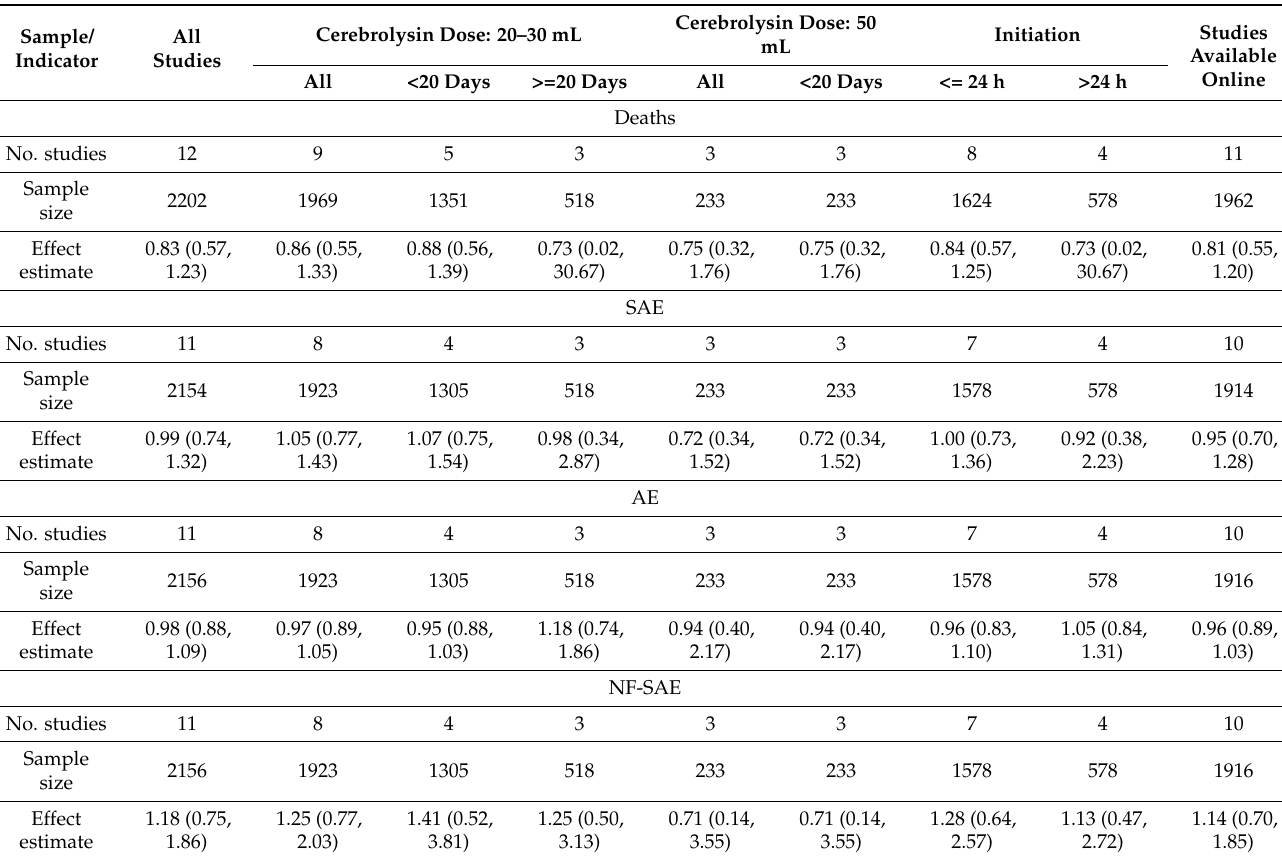
Table 3. Results of subgroup sensitivity analyses. Effect estimates risk ratios are computed using the Mantel–Haenszel method (M-H, random, 95% Confidence